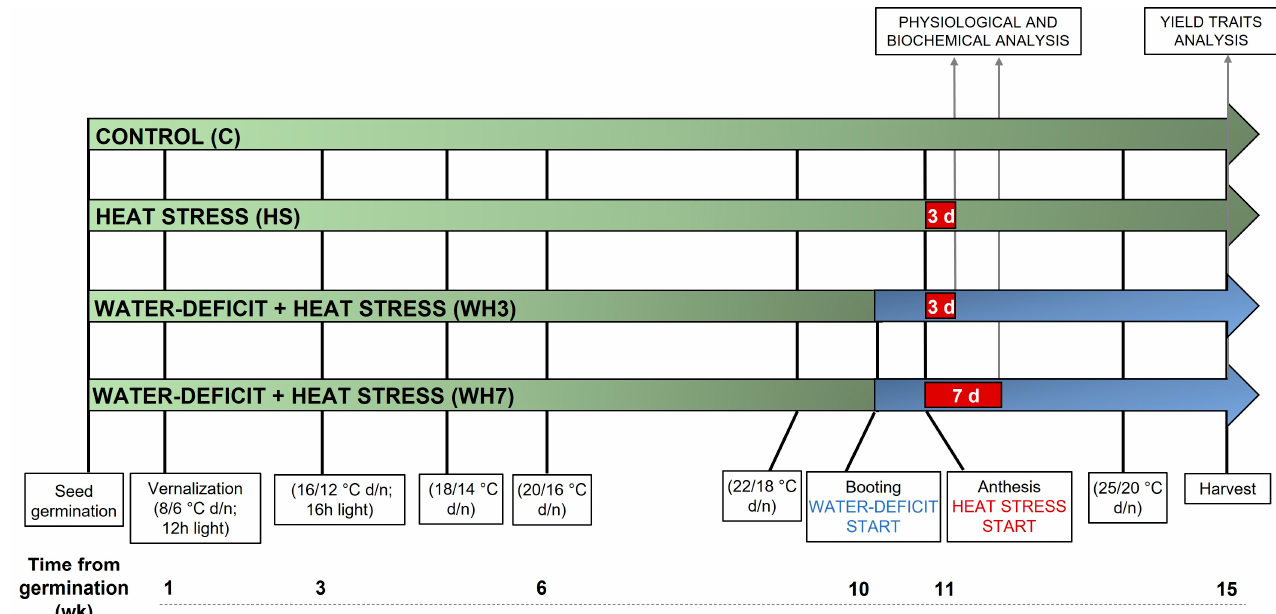
Figure 2. Heat stress application: ( A ) Phenological phase of the main tiller at the time of stress application, corresponding to anthesis (Zadoks scale 61–65). ( B ) Procedure followed for heat treatment, performed for three consecutive days in the heat stress experiment, and for three or seven consecutive days in the combined heat + water-deficit stress experiments.